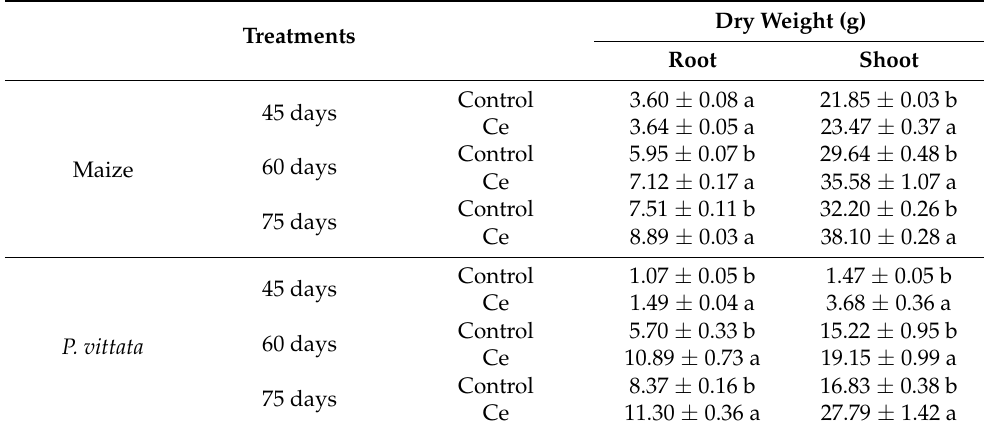
Table 2. Effects of colonization by Ce on the maize and P. vittata biomass under arsenic stress in different periods.